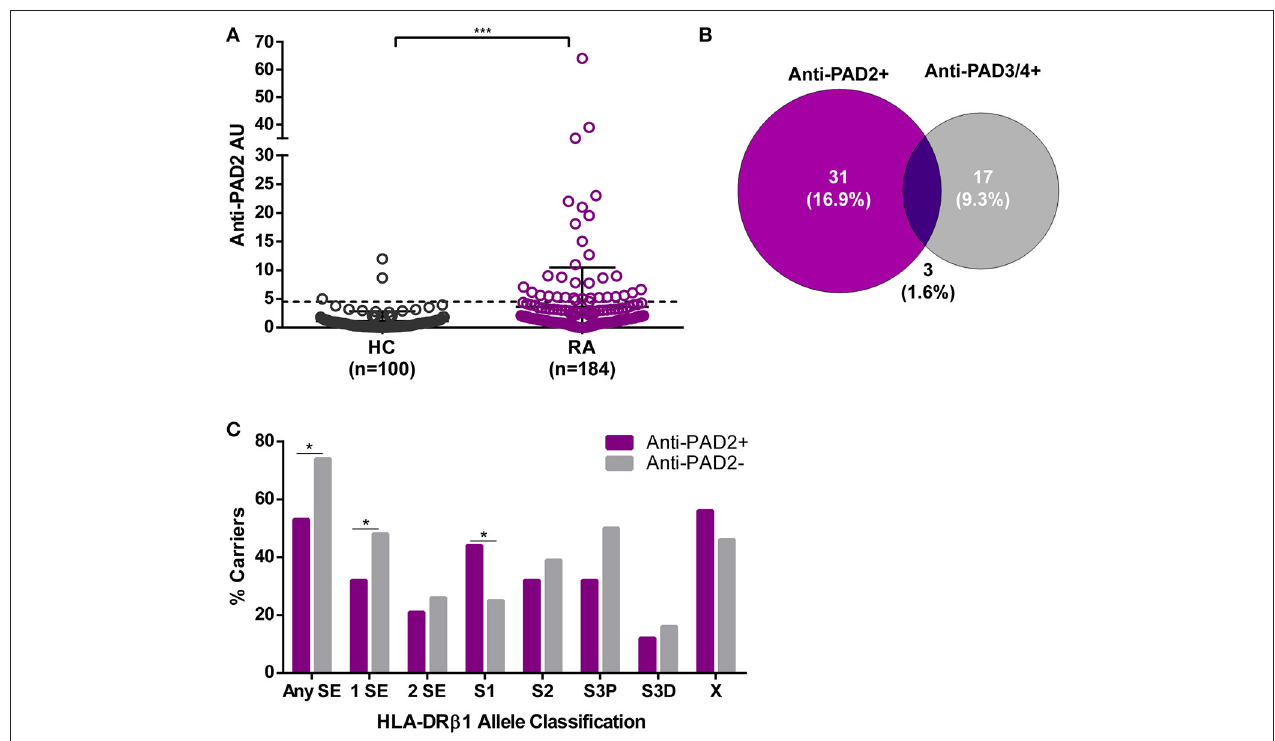
FIGURE 1 | Anti-PAD2 antibodies are found in a serologically and genetically distinct subset of patients with RA. (A) Serum anti-PAD2 antibody arbitrary units (AU) are plotted for each RA patient and healthy control (HC). The cutoff for anti-PAD2 positivity is indicated ( — ) at 2-standard-deviations above the mean of the HC samples (Anti-PAD2AU = 4.5). The median anti-PAD2 level in patients was compared to that of the healthy controls and a significant p < 0.001 is indicated (***). (B) A Venn diagram was created to illustrate the serologic overlap between anti-PAD2 and anti-PAD3/4 antibodies in the n = 183 patients for which both antibodies were measured. (C) The percentage of patients carrying different classes of HLA-DR alleles (% carriers) is shown on the y-axis according to anti-PAD2 antibody status, indicated on the x-axis. The % carriers for each HLA-DR class was compared between anti-PAD2 negative (gray bars) and anti-PAD2 positive (purple bars), and a p < 0.05 was indicated